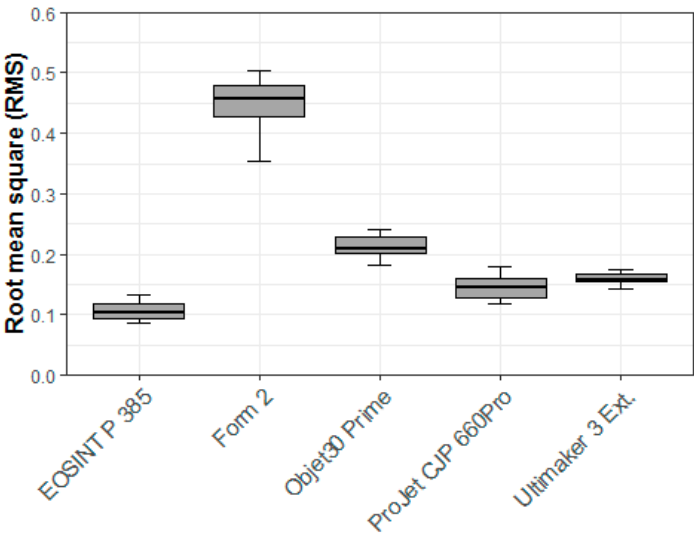
Figure 9. Box plot demonstrating trueness RMS (mm) values by 3D printer type.